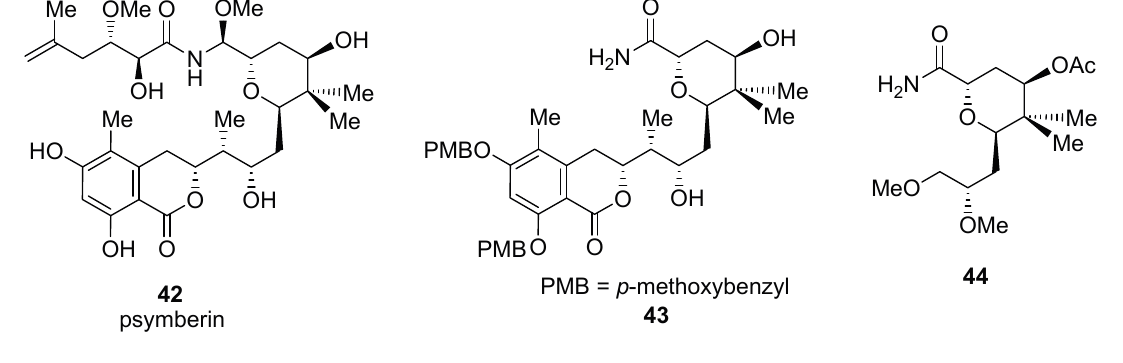
Figure 3. Structure of psymberin and amides 43 – 44